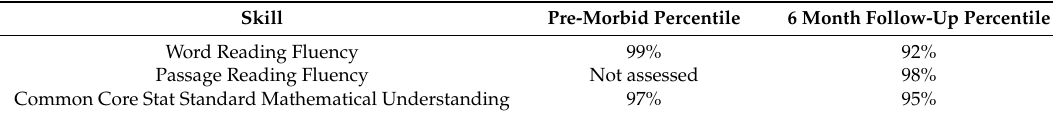
Table 1. Case study school performance pre- and post-morbid.